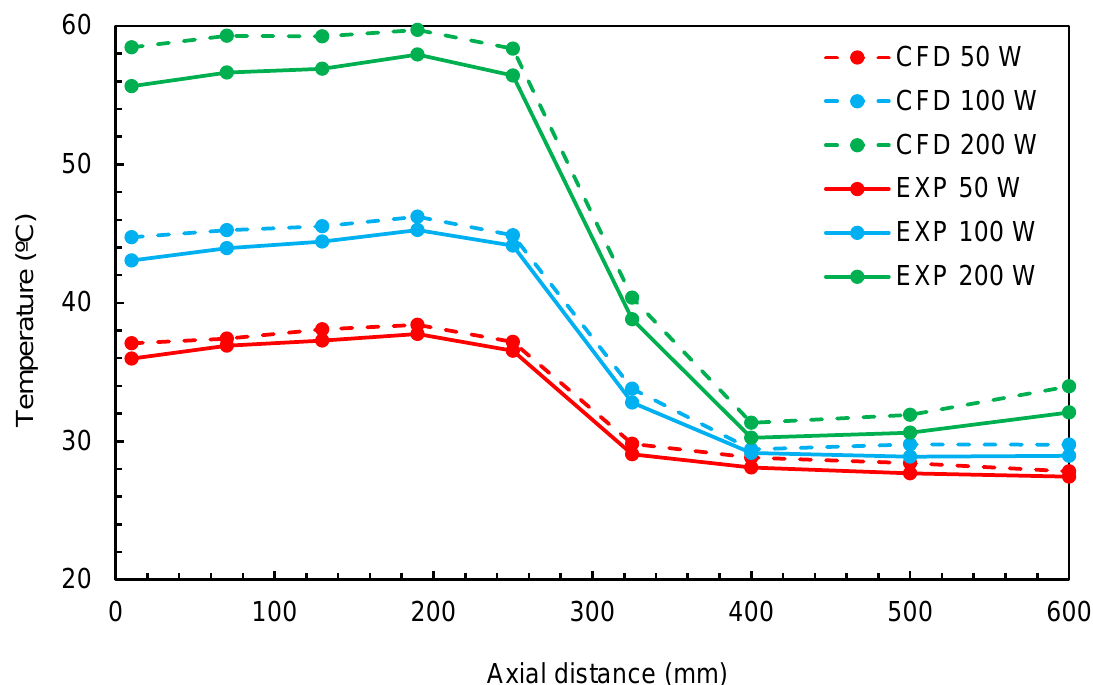
Figure 8. Temperature variation with length of the THP (FR = 50%, inclination angle = 45 °C).